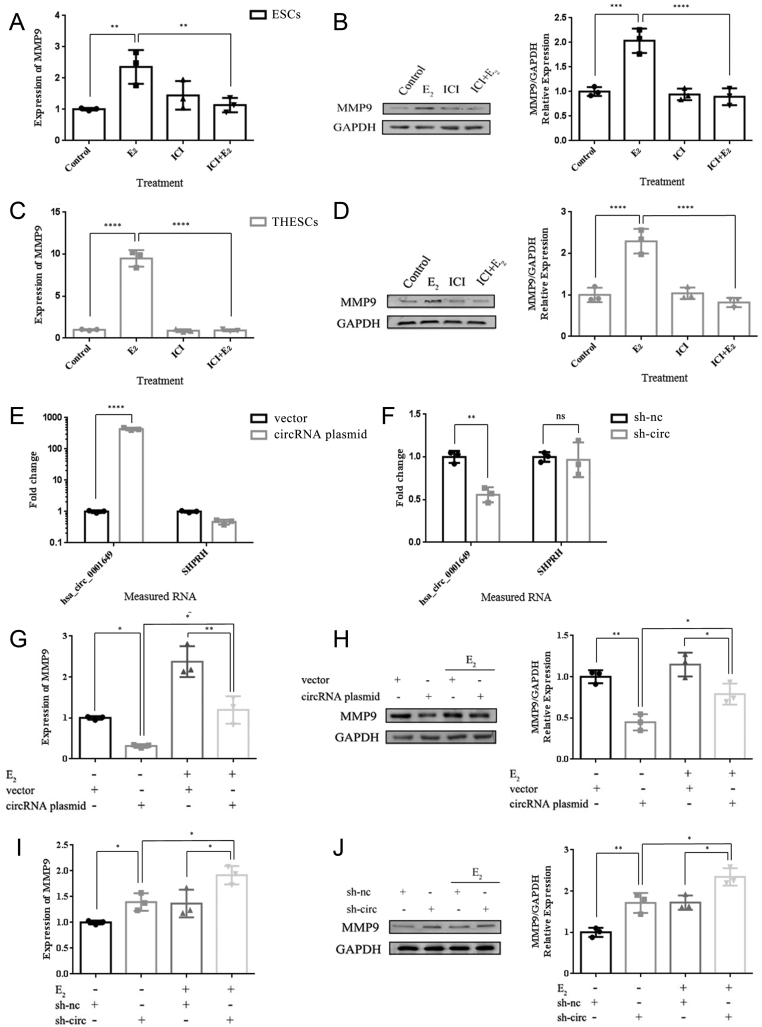
Effects of hsa_circ_0001649 on estrogen (E2)-mediated MMP9 expression in ESCs and ThESCs. (A, B, C and D) MMP9 mRNA and protein expression in ESCs and ThESCs treated with vehicle-only controls, E2, ICI and E2 + ICI. (E) hsa_circ_0001649 and SHPRH (negative control) expression in ThESCs transfected with a pcDNA3.1 vector overexpressing hsa_circ_0001649 (circRNA plasmid) or an empty vector (vector). (F) hsa_circ_0001649 and SHPRH expression in ThESCs transfected with hsa_circ_0001649 shRNA (sh-circ) or control shRNA (sh-nc). (G and H) MMP9 mRNA and protein expression in ThESCs transfected with vector, circRNA plasmid, vector + E2, and circRNA plasmid + E2. (I and J) MMP9 mRNA and protein expression in ThESCs transfected with sh-nc, sh-circ, sh-nc + E2, and sh-circ + E2. RNA expression was measured by qRT-PCR and protein expression by Western blotting; the results are represented as the fold change compared to the vehicle-only controls. The data are presented as the mean ± s.d. of three independent experiments. *P < 0.05; **P < 0.01; ***P < 0.0001; and ****P < 0.0001 by one-way ANOVA and Student’s t-test. n.s., not significant.